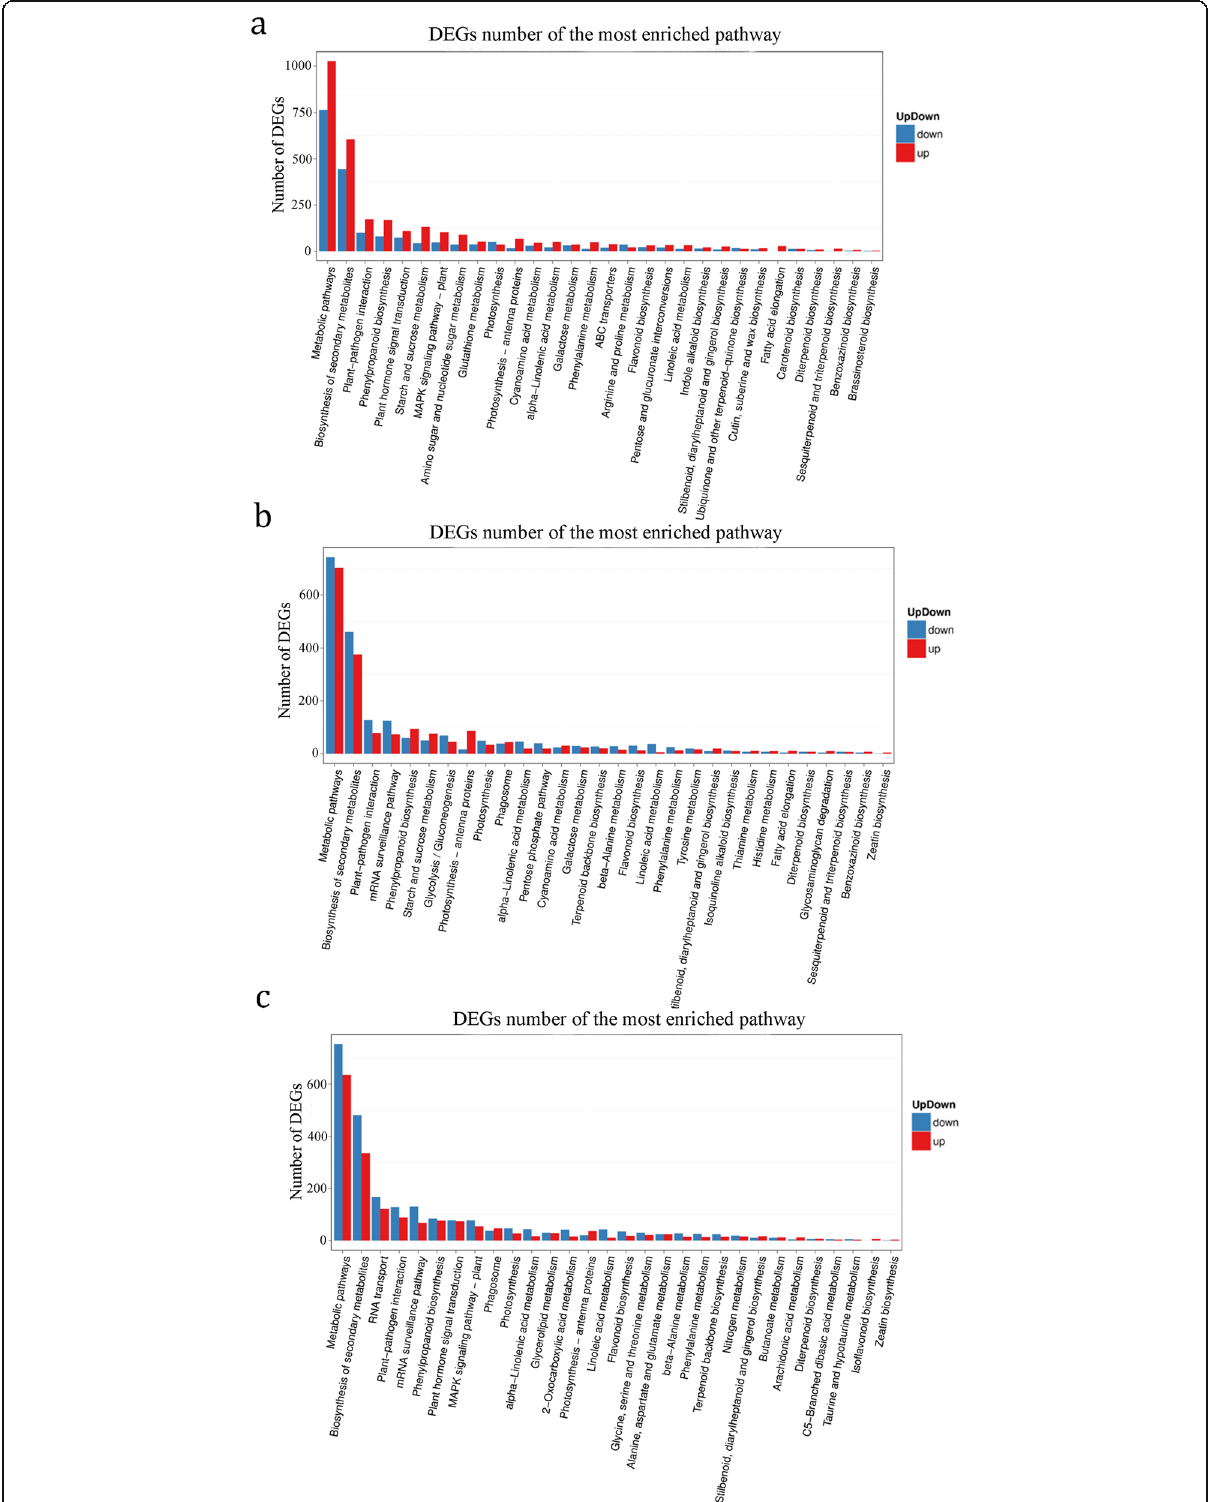
Fig. 7 KEGG pathway enrichment of DEGs between BYDV-GAV-inoculated P. huashanica at different time after inoculation and mock-inoculated samples, respectively. Enriched KEGG pathway terms between BYDV-GAV-inoculated P. huashanica at 3 dpi and mock (a) , 7 dpi and mock (b) , 14 dpi and mock (c) , The X-axis represents the functional category and the Y-axis represents the number of